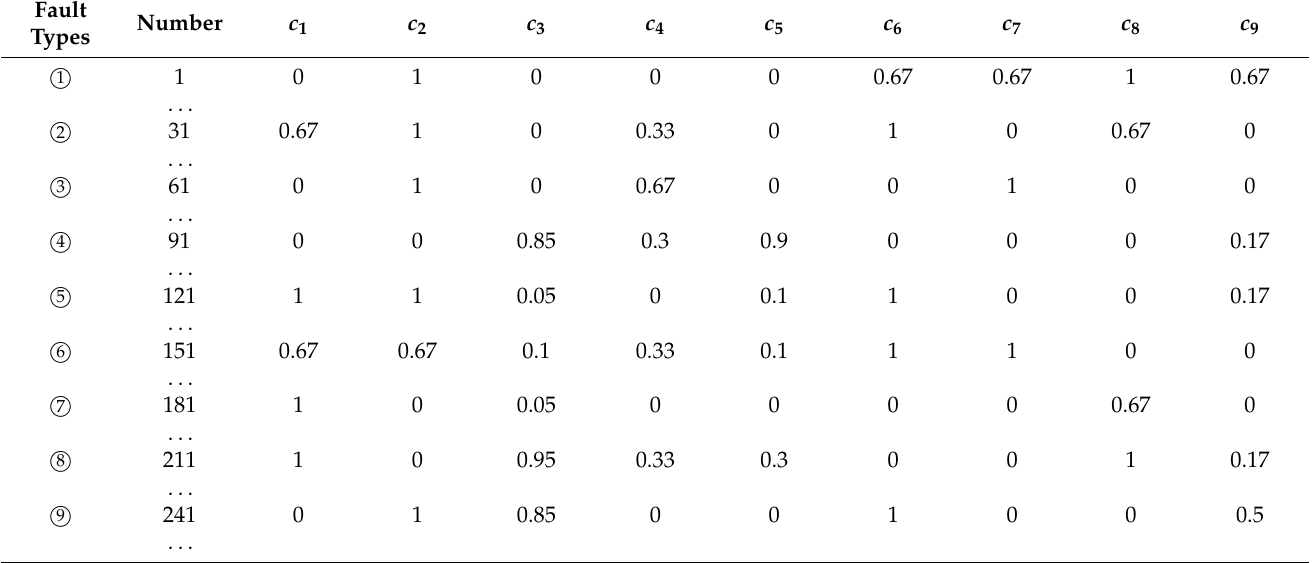
Table 6. Fault characteristic sequence sample.